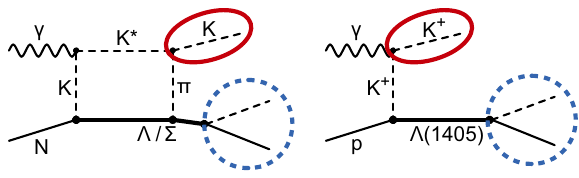
Figure 1. Example of kinematics ideally suited for